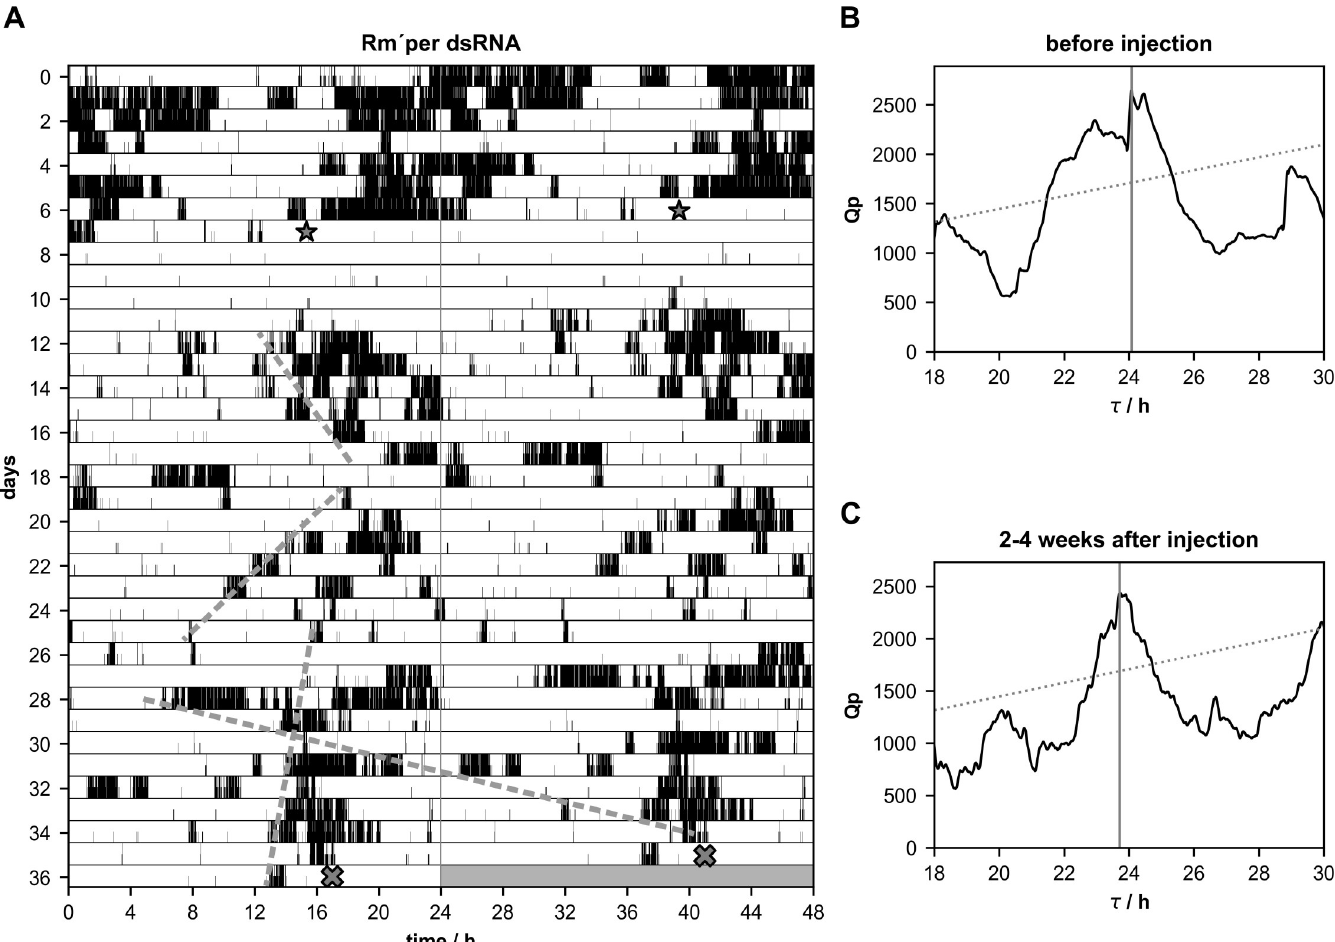
Fig 4. A-C. Most Madeira cockroaches retained circadian rhythmicity (n = 8 of 12), but expressed weaker (n = 6 of 12) and/or desynchronized rhythms (n = 3 of 12) with more than one period( τ ) after injections of Rm´per dsRNA. (A) Double-plotted running wheel activity of a Madeira cockroach in constant darkness 7 days before, and 29 days after the injection of Rm´per dsRNA (star). At day 36 of the locomotor activity recording the cockroach was sacrificed (cross) and qPCR was used to confirm the knockdown. Chi-square periodogram analysis of the number of running wheel turns indicated significant rhythmicity with a period of 24.08 h 1–7 days before Rm ´per dsRNA injection (B) and 23.72 h 2–4 weeks after the injection (C) . Already before injection the broad, two peaked distribution of significant rhythmicity indicated only loosely coupled oscillators controlling locomotor rhythms in this individual cockroach. Knockdown of Rm´per mRNA further dissociated underlying short and long rhythmic components (dashed lines), but did not completely delete rhythmicity over the course of 4